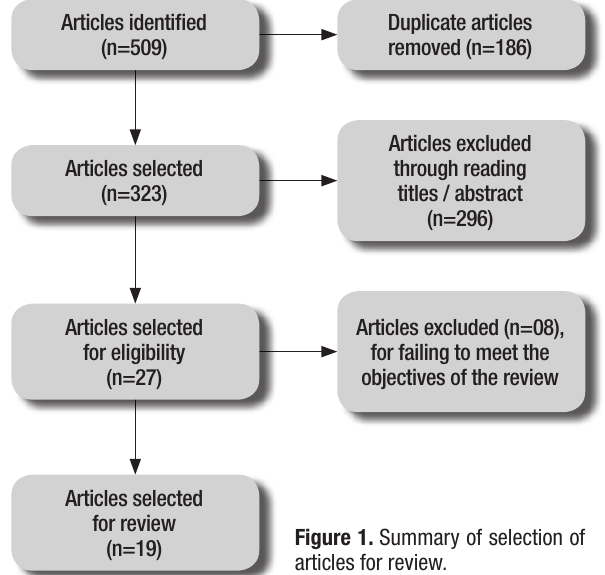
Figure 1. Summary of selection of articles for